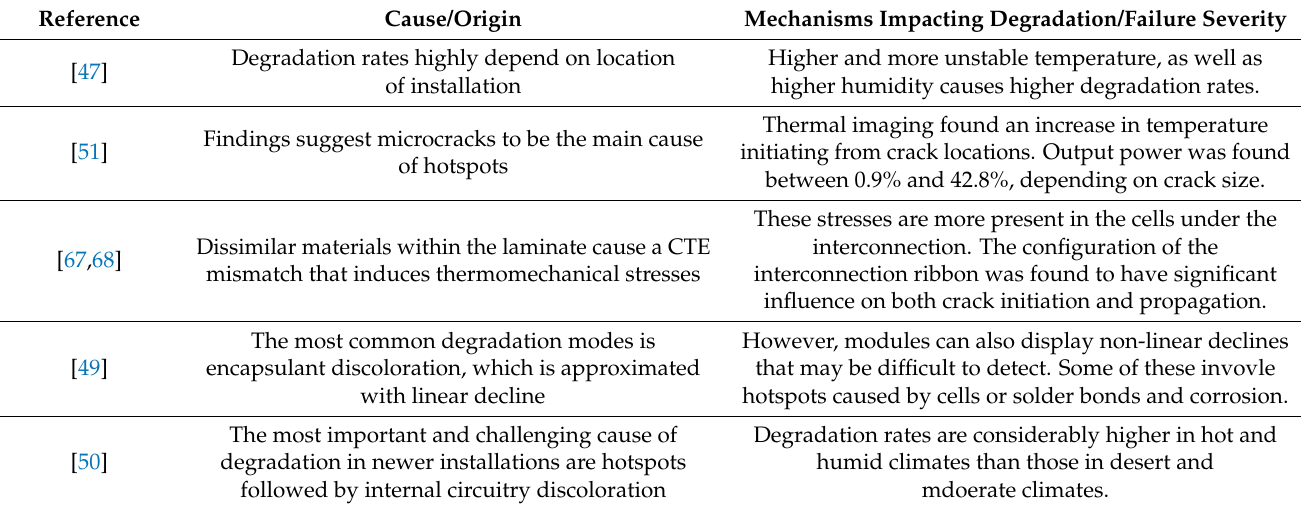
Table 3. Summary of the key findings from the literature outlining the origin and mechanisms of microcracks and hotspots.